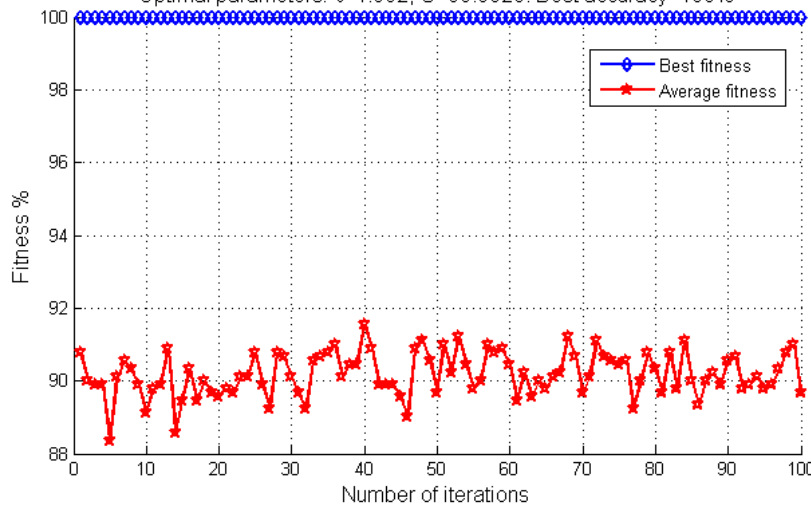
Figure 5. The fitness curve of particle swarm optimization. Table 3. Detection rate of the testing sample set in the first experiment.